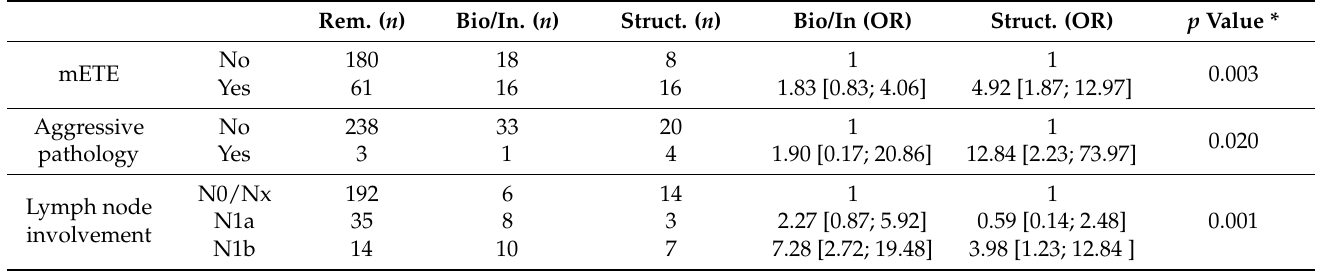
Table 4. Multivariate analysis of factors associated with clinical outcome at 5 years. Rem. ( n